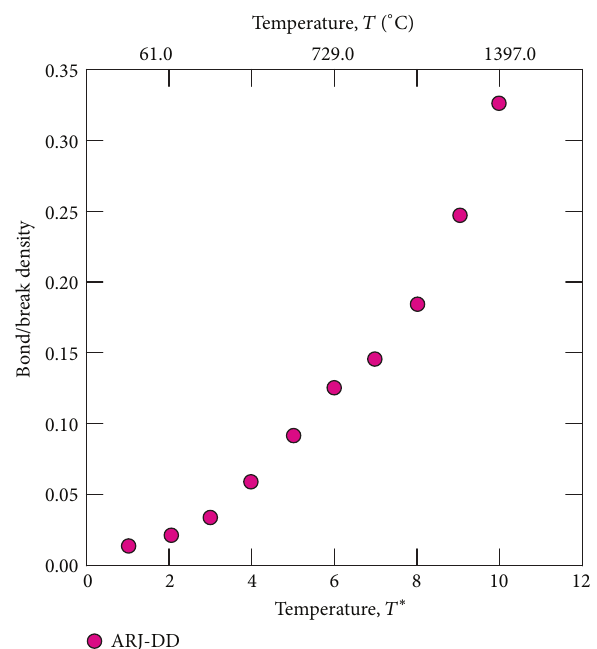
Figure 16: Effect of temperatures on the bond/break density of ARJ-DD on DLC surface.